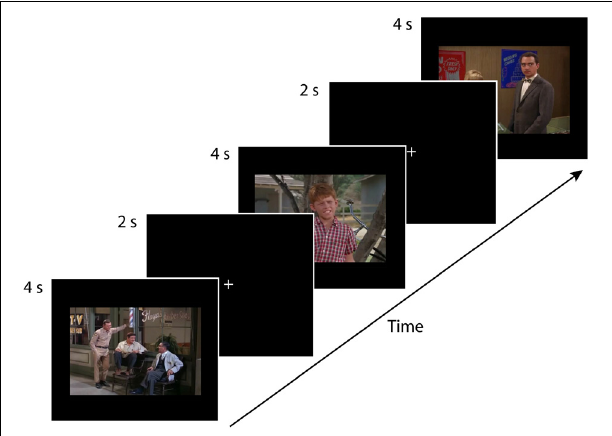
FIGURE 1 | This eye-tracking experiment consisted of four conditions. (1) single-character-static, (2) multiple-characters-static, (3) single-character- dynamic, and (4) multiple-characters-dynamic, with each condition consisting of six trials. Each participant saw the 24 test trials in a random order. Each trial consisted of a 2-s central white fixation point on a black background followed by the presentation of the 4-s stimulus. The figure depicts three static trials (multiple-character, single-character, multiple-character). An example of a single-character-dynamic trial is provided in the supplementary material available